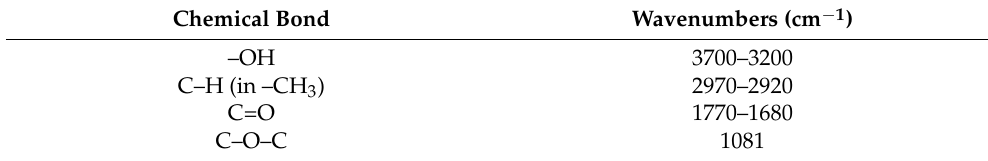
Table 1. The wavenumbers corresponding to the main chemical bond in alicyclic epoxy resin.